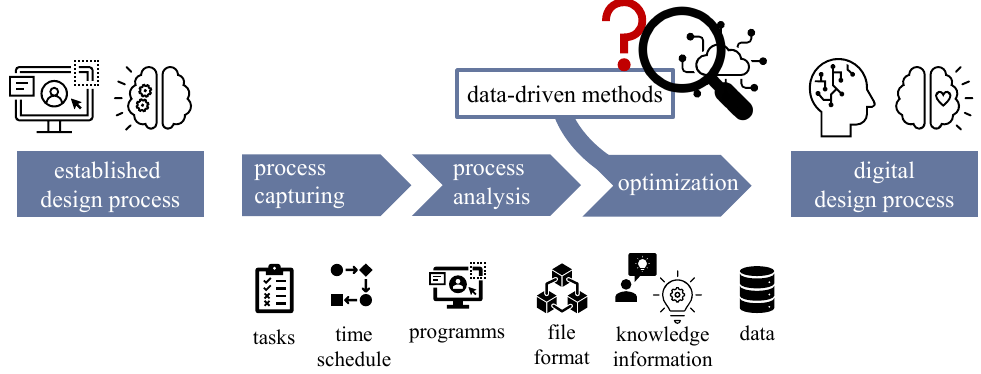
Figure 4. Process for integrating Digital Engineering methods into product